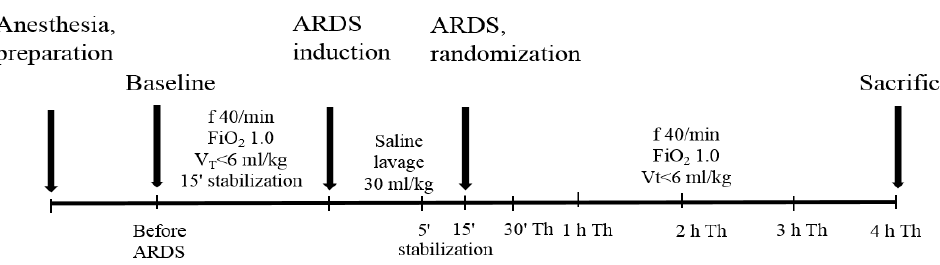
Figure 6. Timeline representation of the experimental protocol. ARDS = acute respiratory distress syndrome, V T = tidal volume, f = frequency, FiO 2 = fraction of inspired oxygen.